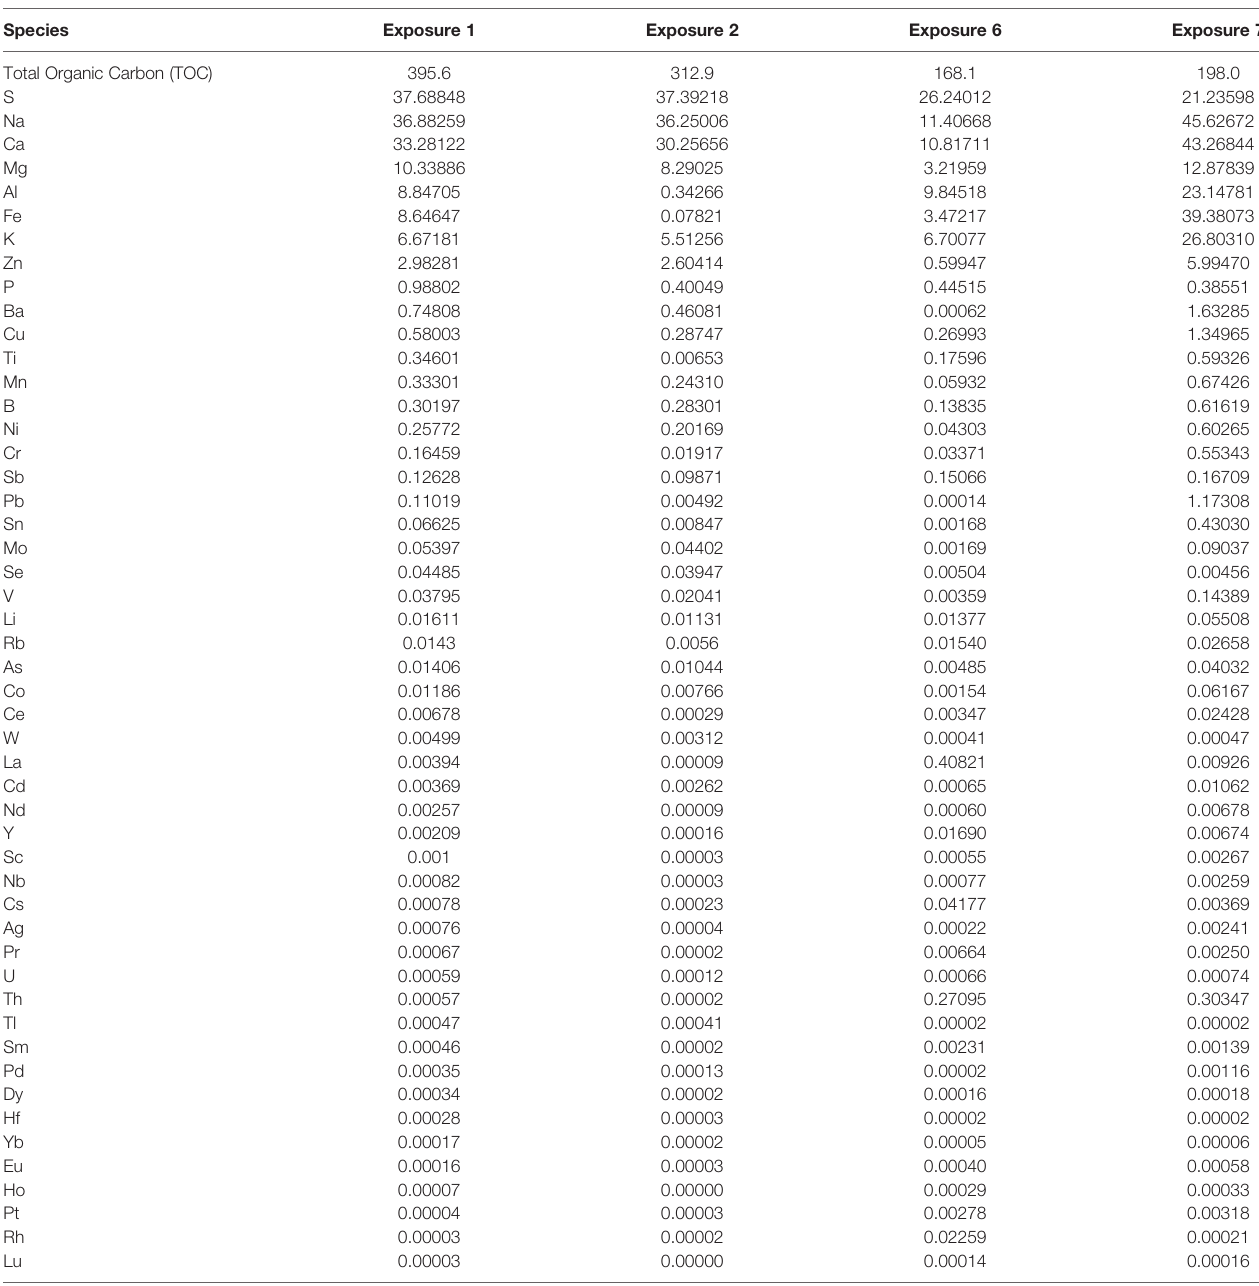
Table adapted from Liu et al. These batches of nPM have been reported from prior experiments (16). Units are ng/ m g of PM mass. The following elements are important for redox-active responses: transition metals Fe, Cu, Ti, Mn; Post transition: Al, Zn, Pb, Sn; Alkali and earth metals: Na, Ca, Mg, K; Non-metals: S, P, Se